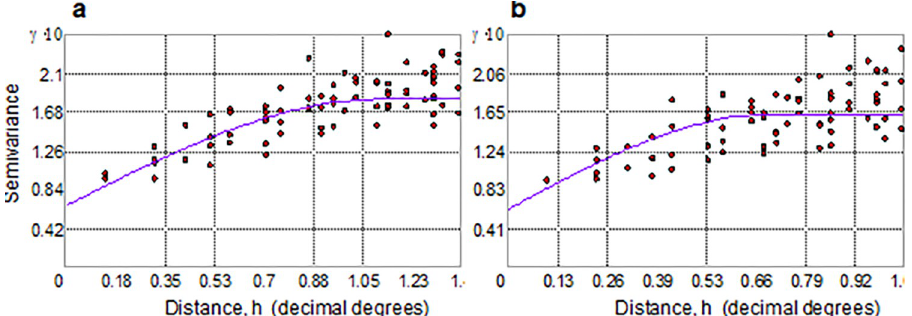
Fig 5. Modelling of spatial dependence to instructing kriging interpolation. Experimental semivariogram (dots) with permissible spherical model estimates (violet curve) at a) threshold z 3.0 MJ hm -2 h -1 ( b ). Units of the semivariance γ are multiplied by